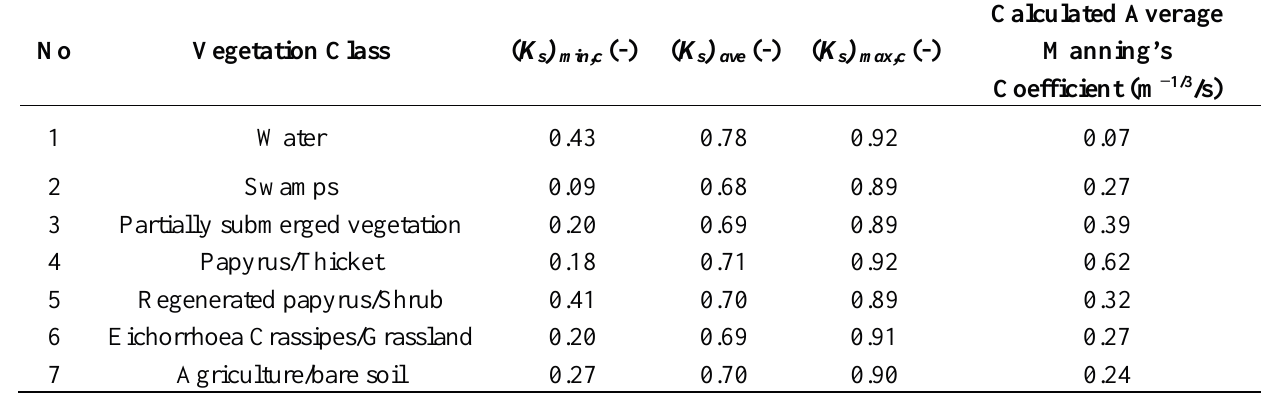
Table 5. Relative surface roughness and calculated average Manning’s for different vegetation